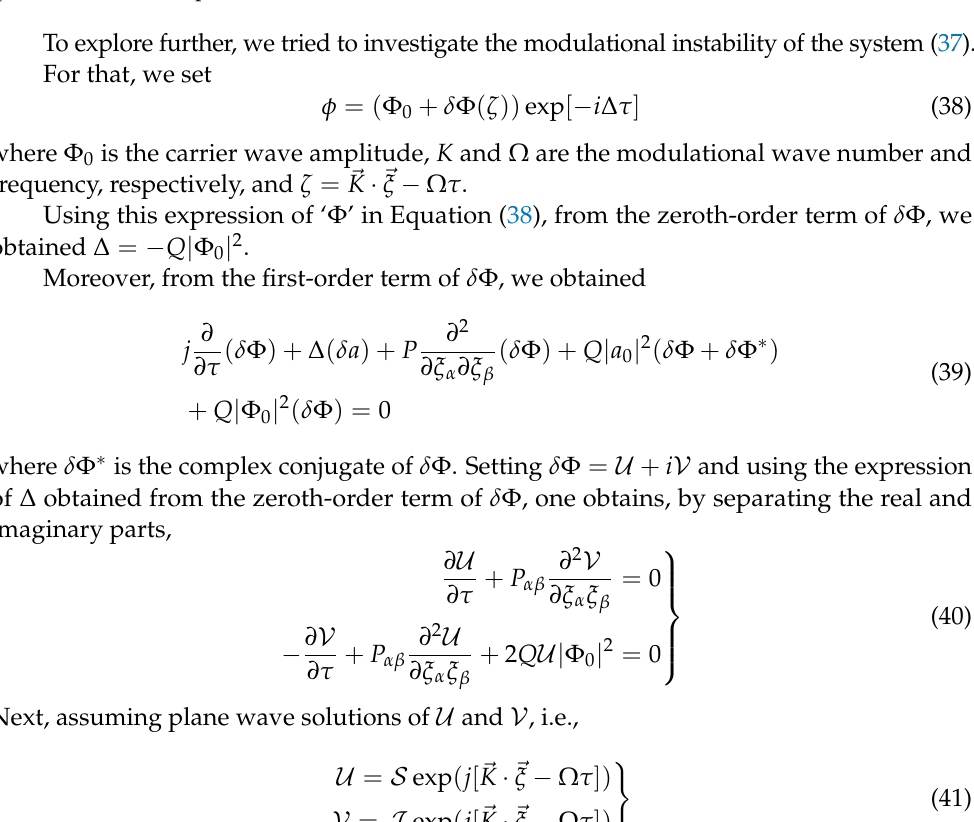
Figure 9. Contour plot of the nonlinear coefficient Q . The variation is shown with respect to the quantum diffraction parameter H and wave vector ( k x